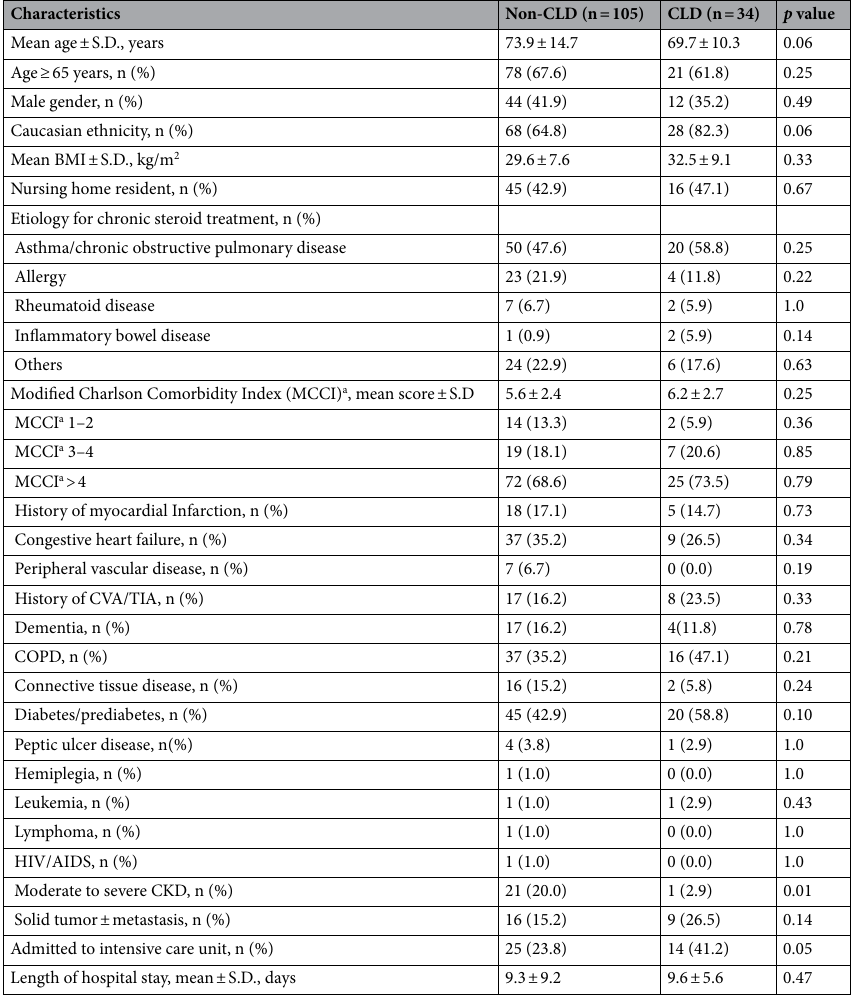
Table 1. Characteristics of admitted COVID-19 patients with or without chronic liver disease (CLD) on long- term corticosteroid treatment for co-existing conditions. a Modified Charlson Comorbidity Index: liver disease not included in calculation of